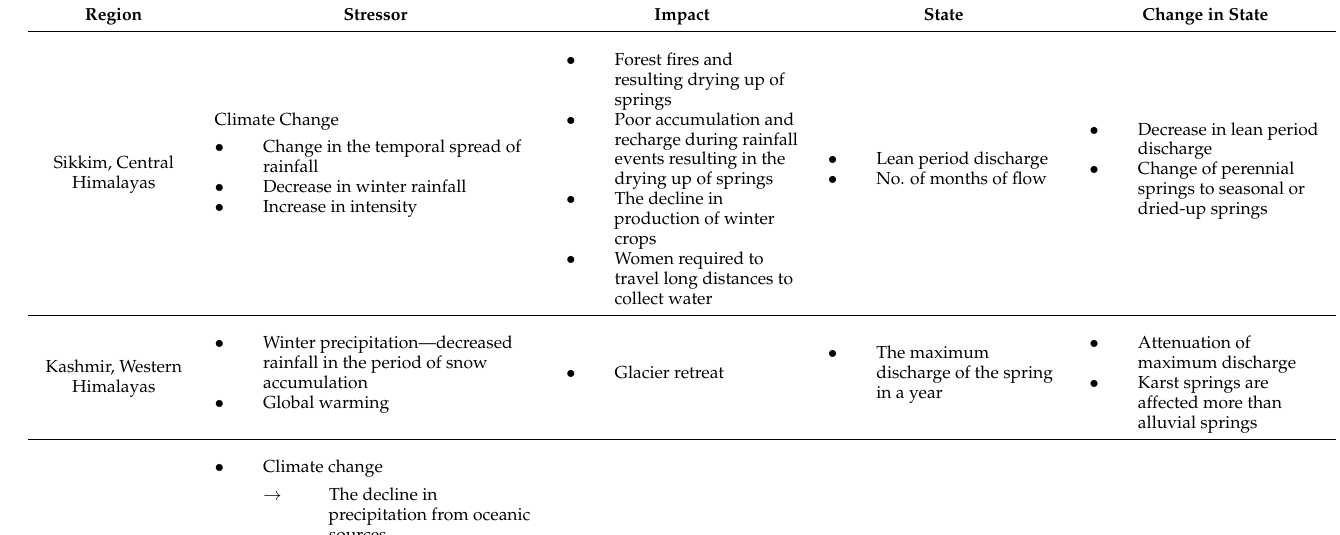
Table 5. Impact of ‘stressors’ on the ‘state’ of Indian Himalayan